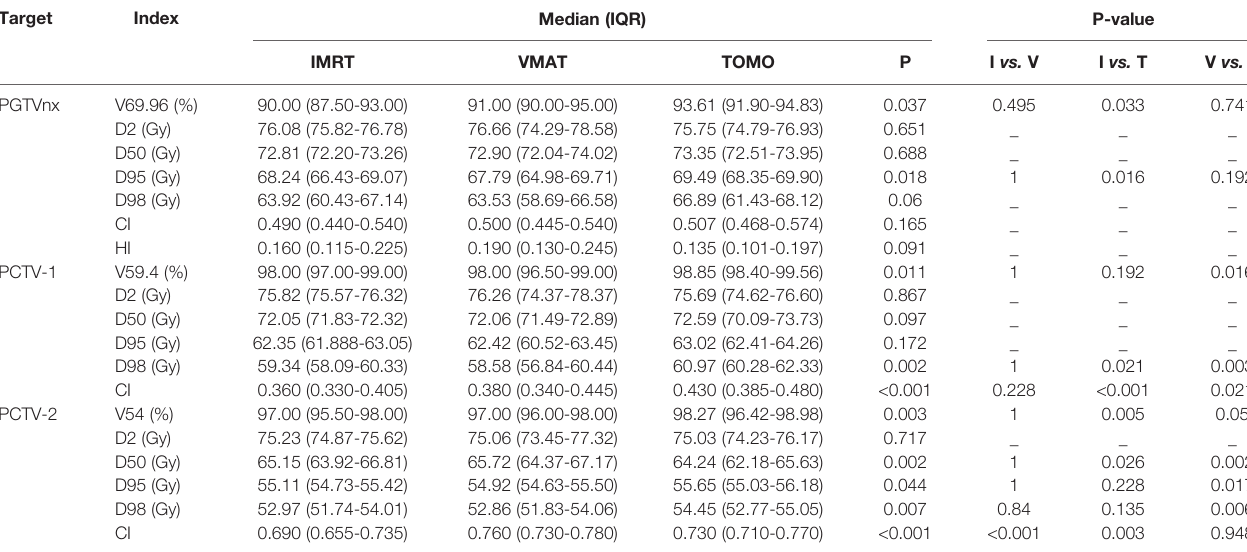
TABLE 8 | Comparison of targets in T 3-4 NPC